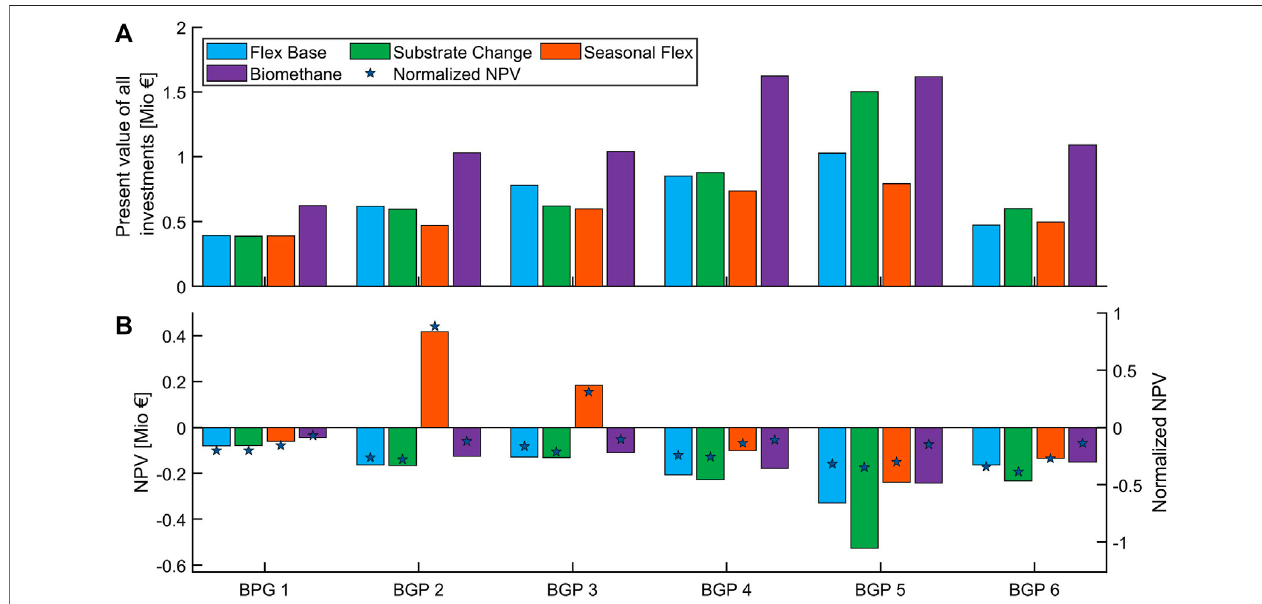
FIGURE5| Comparisonofinvestments (A) ,netpresentvalue(NPV),andnormalizedNPV (B) forthefollow-upconceptsoftherepresentativebiogasplants(BGPs) in the REF scenario.